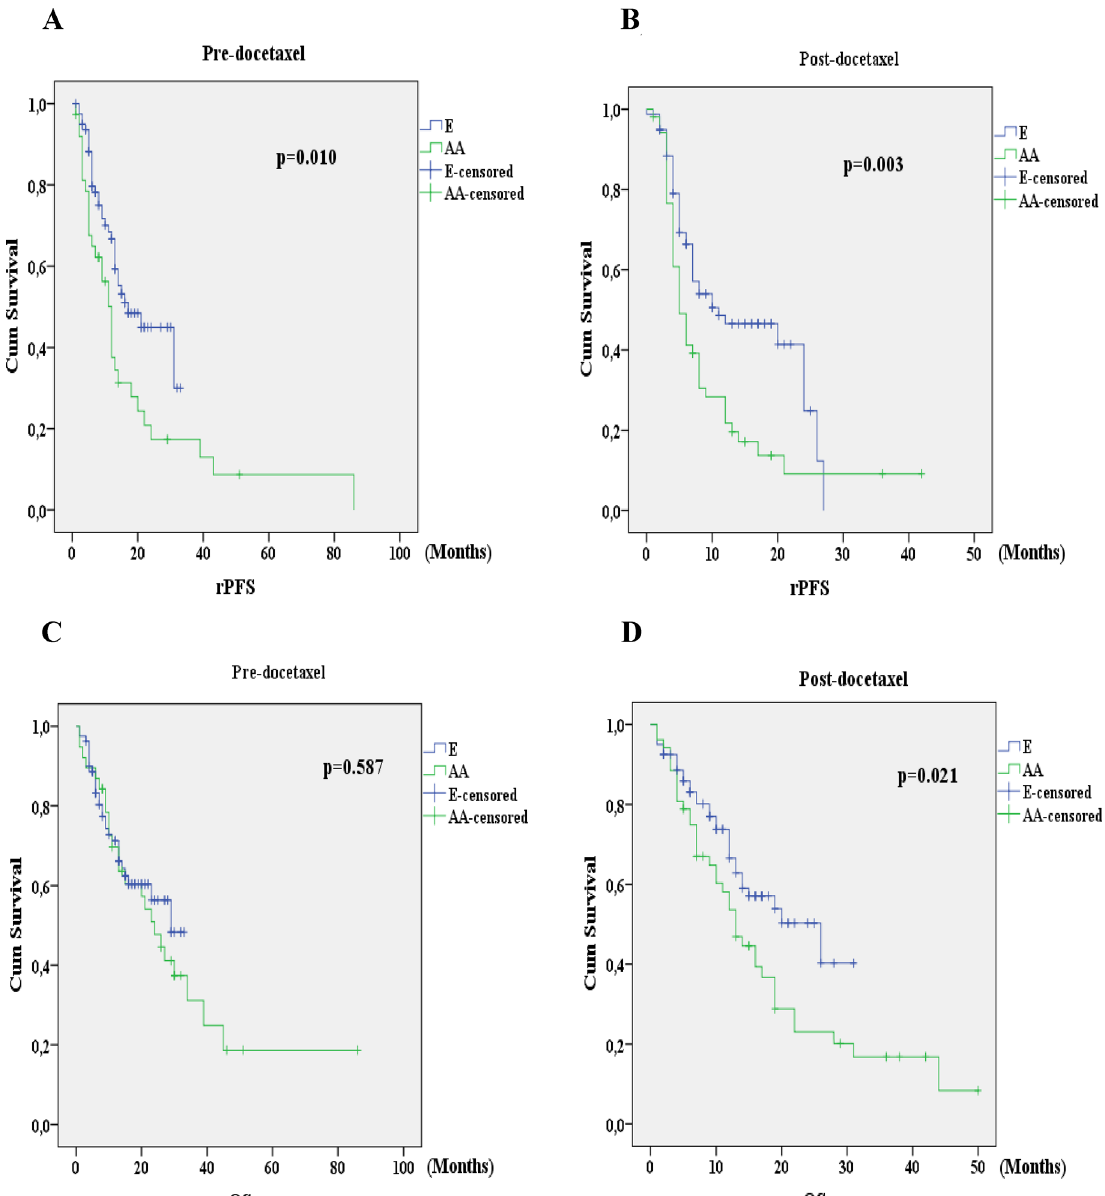
Figure 3. In the pre-docetaxel setting and post-docetaxel setting ( A,B ) Comparison of radiological progression free survival ( C,D ) Comparison of overall survival between two drugs. E enzalutamide, AA abiraterone acetate, rPFS radiological progression free survival, OS overall